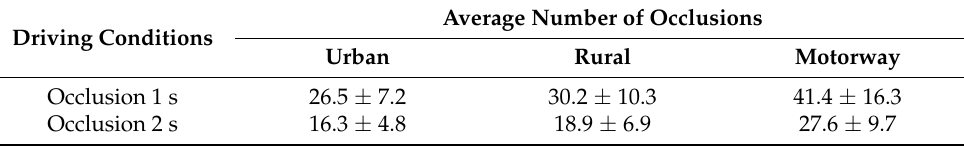
Table 2. Average number of occlusions per occlusion duration and driving scenario. Driving Conditions